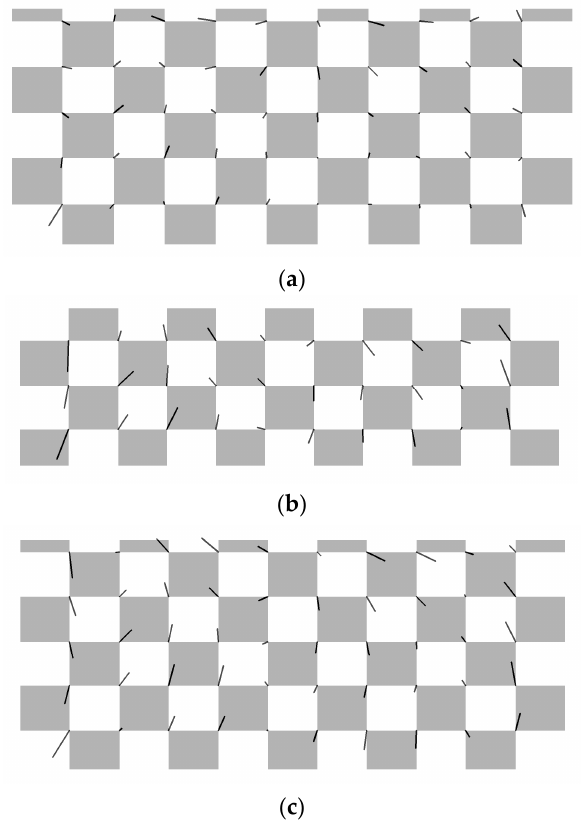
Figure 6. Residuals ( × 50) of the three projector calibration, where: ( a ) Proj1; ( b ) Proj2; ( c )